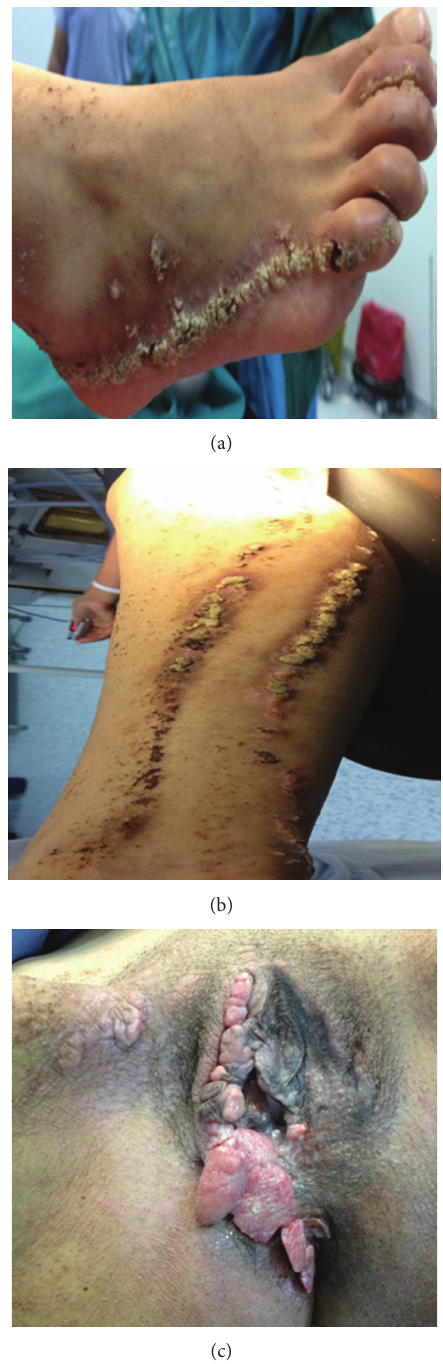
Figure 1: Vulvar and perianal condyloma superimposed ILVEN seen in the right side of the